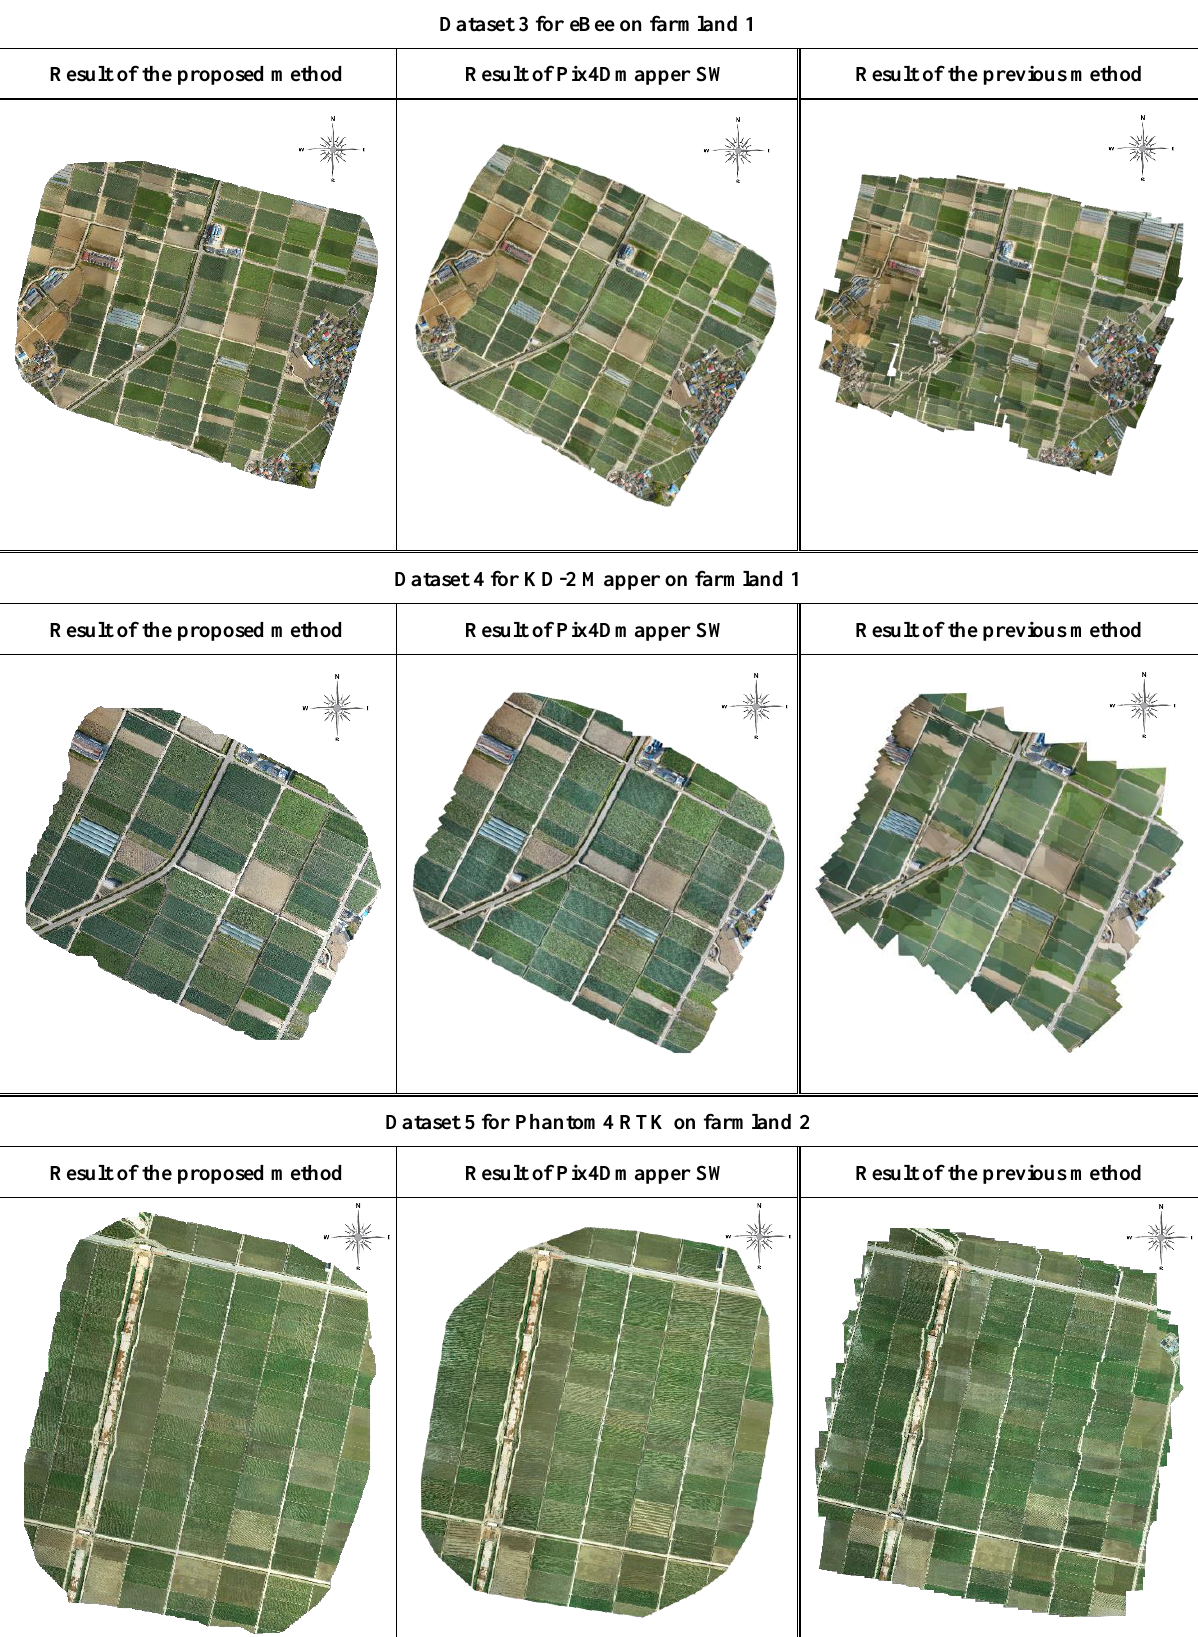
Table 8. Mosaic image of the proposed method, Pix4Dmapper SW, and the previous method